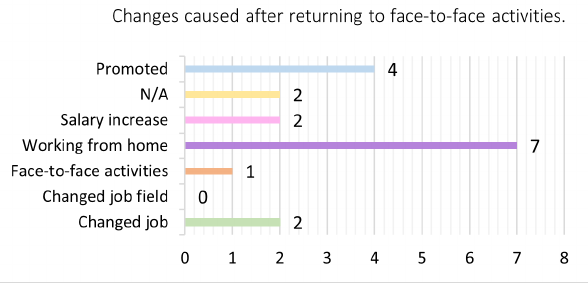
Figure 8. Changes caused after returning to face-to-face